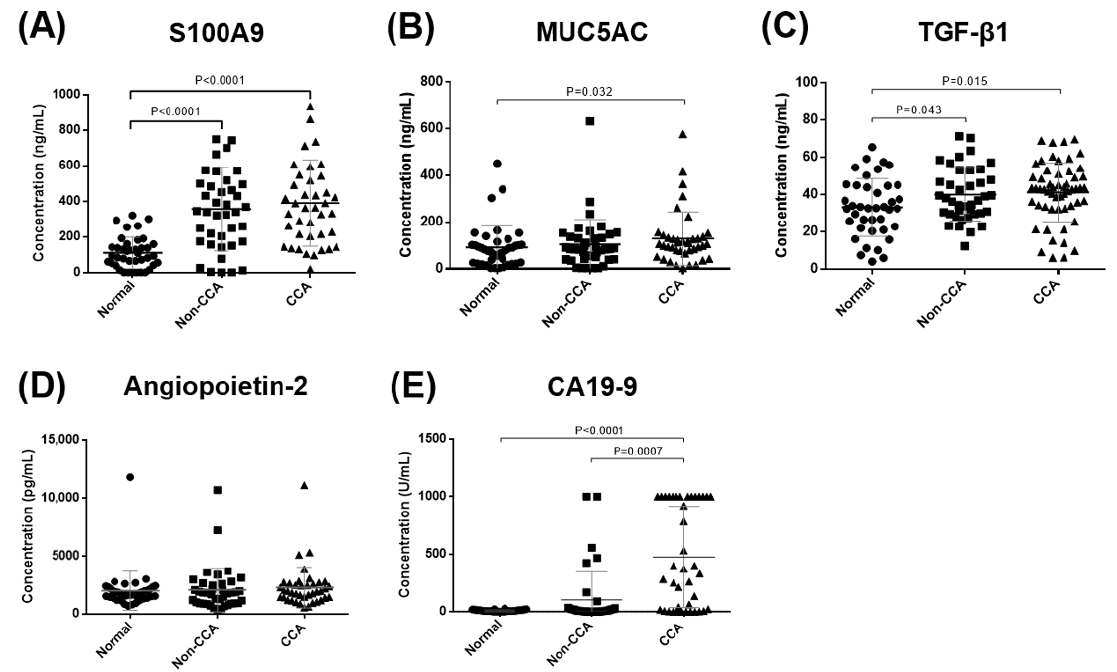
Figure 1. Serum levels of S100A9 ( A ), MUC5AC ( B ), TGF- β 1 ( C ), angiopoietin-2 ( D ), and CA19-9 ( E ) in the normal control group, non-CCA group, and CCA patients. Scatter plots represent mean ± standard deviation (SD). The p value < 0.05 was considered statistically significant when compared in each group.